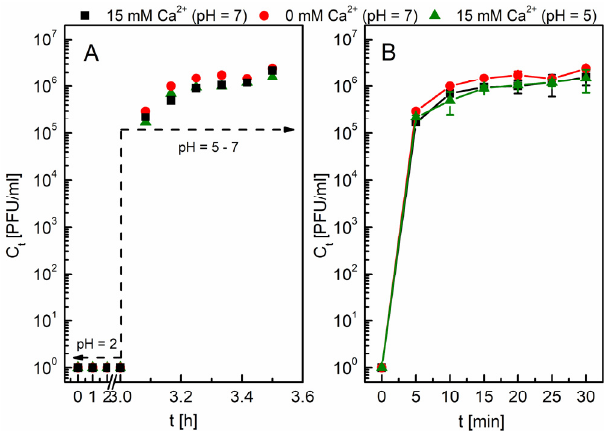
Figure 2. Bacteriophage release from 1.5% TOCNF hydrogel crosslinked in polyHIPE particles. The colors represent the concentration of the ionic crosslinking agent (Ca 2+ ) and the pH of the release medium. The A panel shows the total process of phage release for the first 3 h in medium with pH 2 and afterward in medium with pH 5 or 7. The B panel illustrates only the release after pH switch (after 3 h).